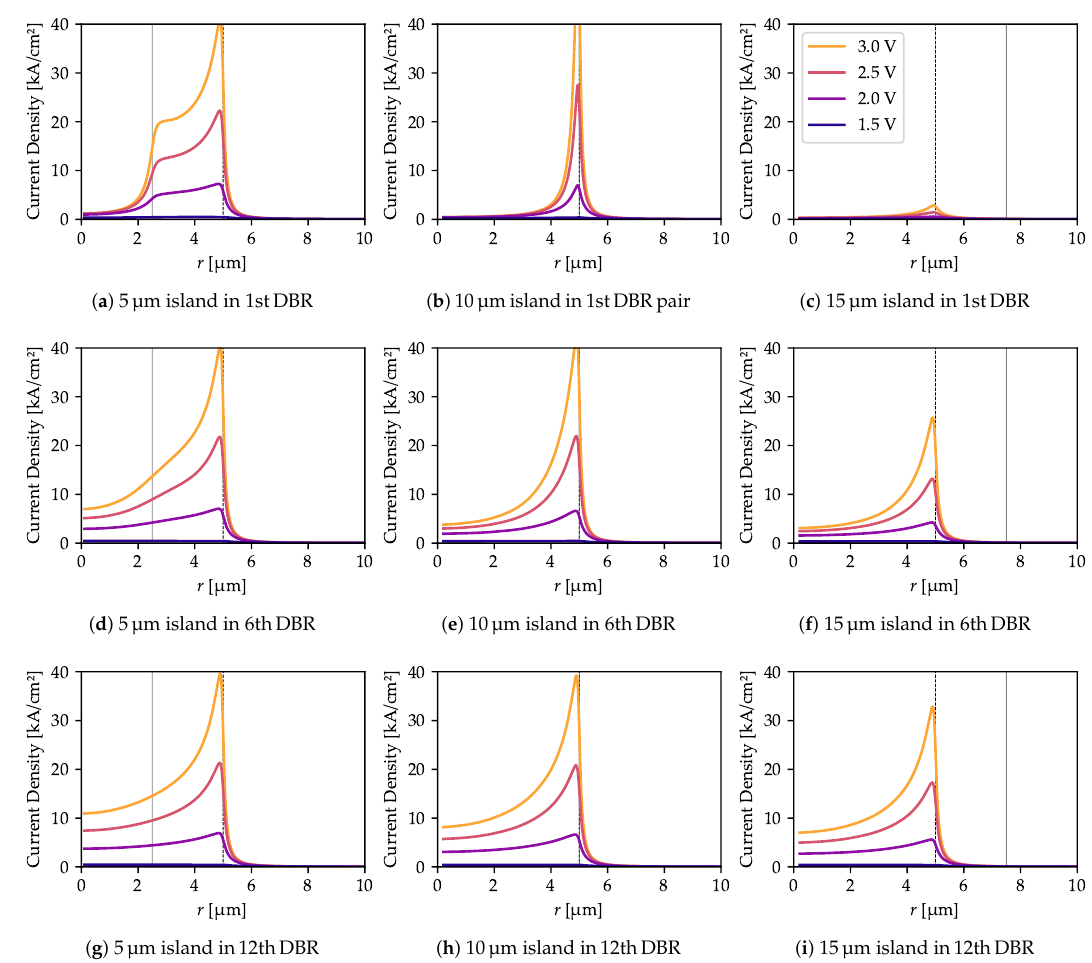
Figure 3. Current density distribution in the active region for several contact-to-contact voltages and with oxide islands of various sizes in different positions. Each figure caption indicates the island diameter and the number of the top DBR pairs in which it is located, counted from the cavity. Current crowding decreases as the island is moved away from the cavity, but becomes larger as the size of the island increases. Large oxide islands strongly increase structure resistivity. Vertical lines indicate the oxide aperture radii (dashed—outer oxidation radius, solid—the island